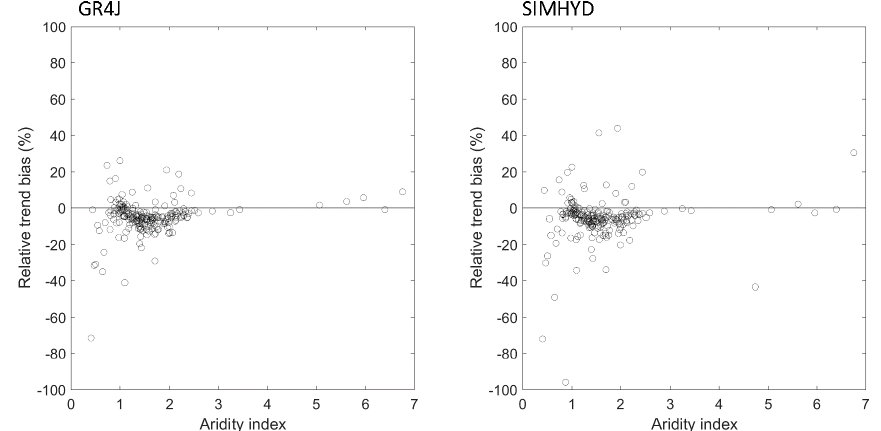
Figure 11. Relationships between relative trend bias (mmyear − 1 year − 1 ) and aridity index for each catchment and for the experiment of the 10% missing data